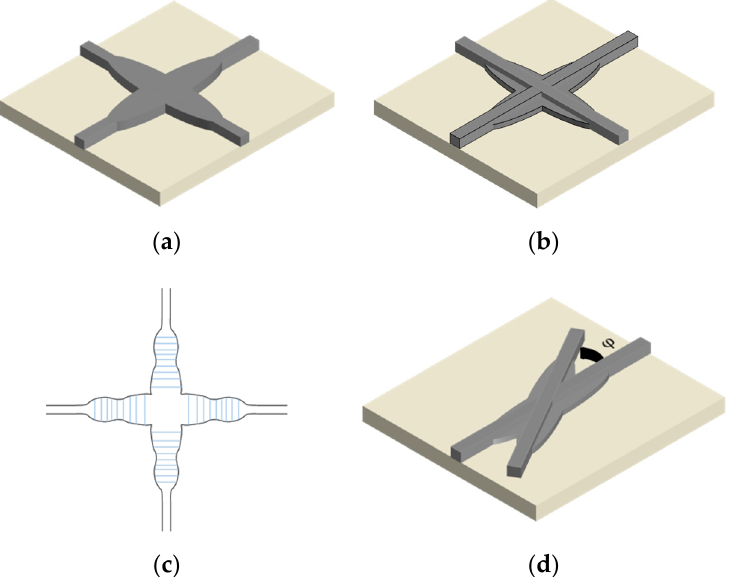
Figure 2. Schematics of ( a ) the shaped taper waveguide crossing and ( b ) the double-etched shaped taper silicon waveguide crossing; ( c ) the top view of the shaped waveguide crossing designed by the genetic algorithm (GA); ( d ) Schematic of the titled double-etched silicon waveguide crossing, φ represents the crossing angle.